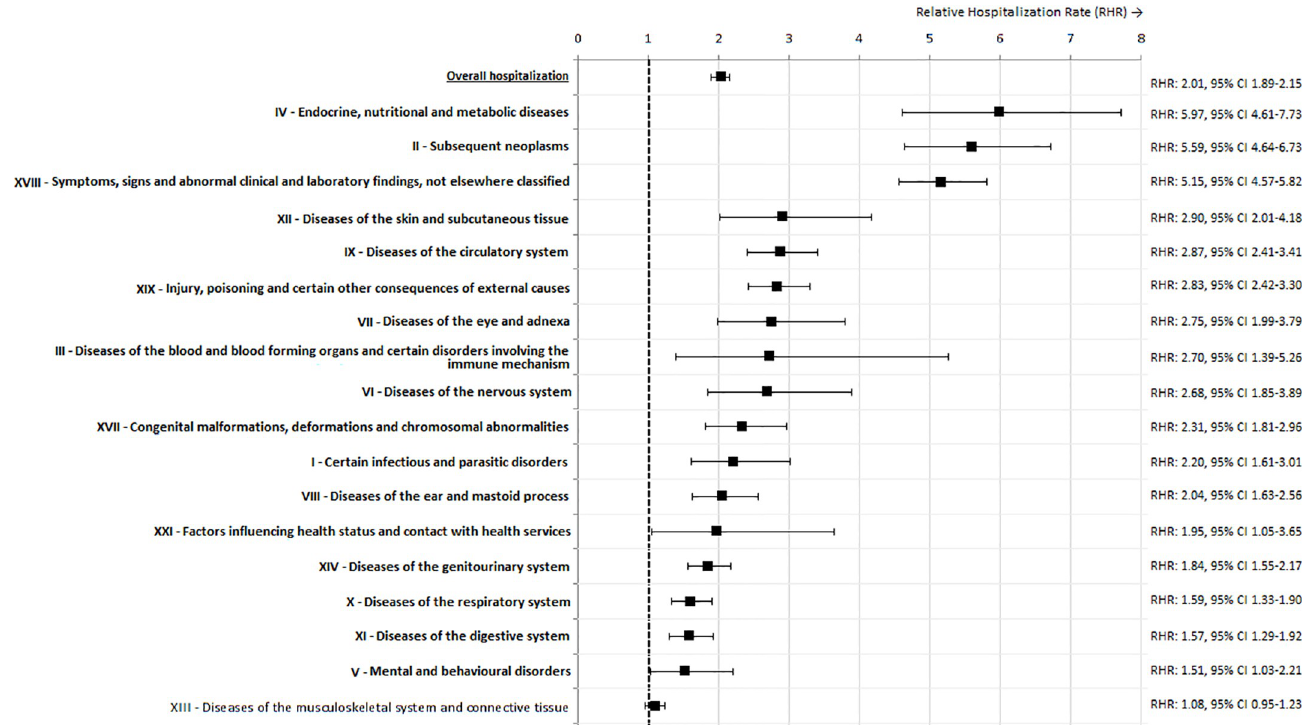
Fig 1. Relative hospitalization rates for five-year childhood cancer survivors as compared to the reference population, overall and for each type of hospitalization related health condition. Abbreviations: 95% CI: 95% confidence interval, RHR: relative hospitalization ratio.